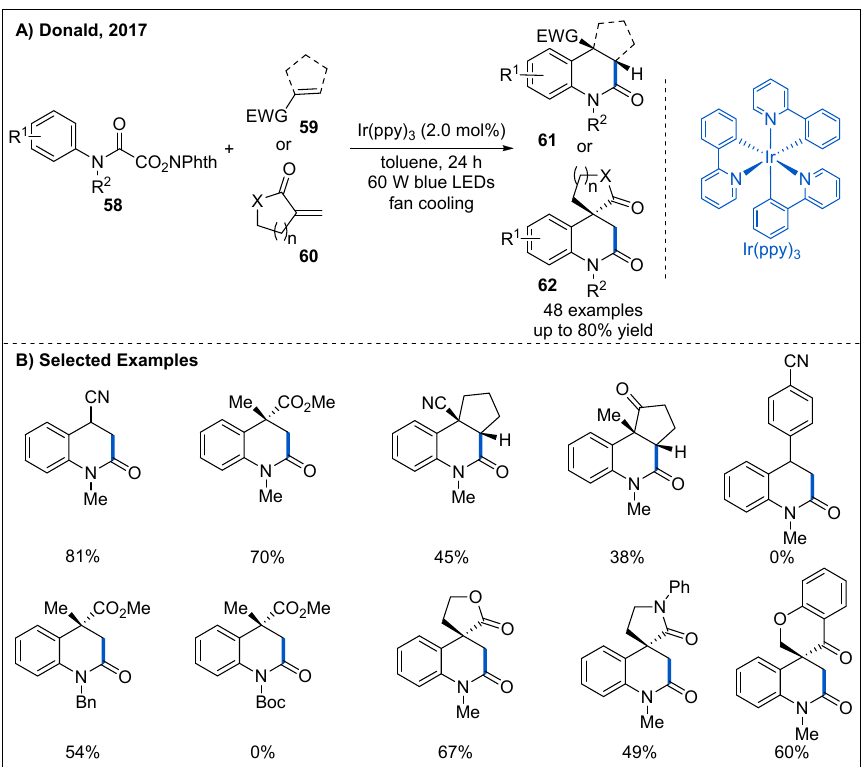
Figure 19. Amide synthesis by photoredox-catalyzed carbamoyl radical addition to heteroarenes.